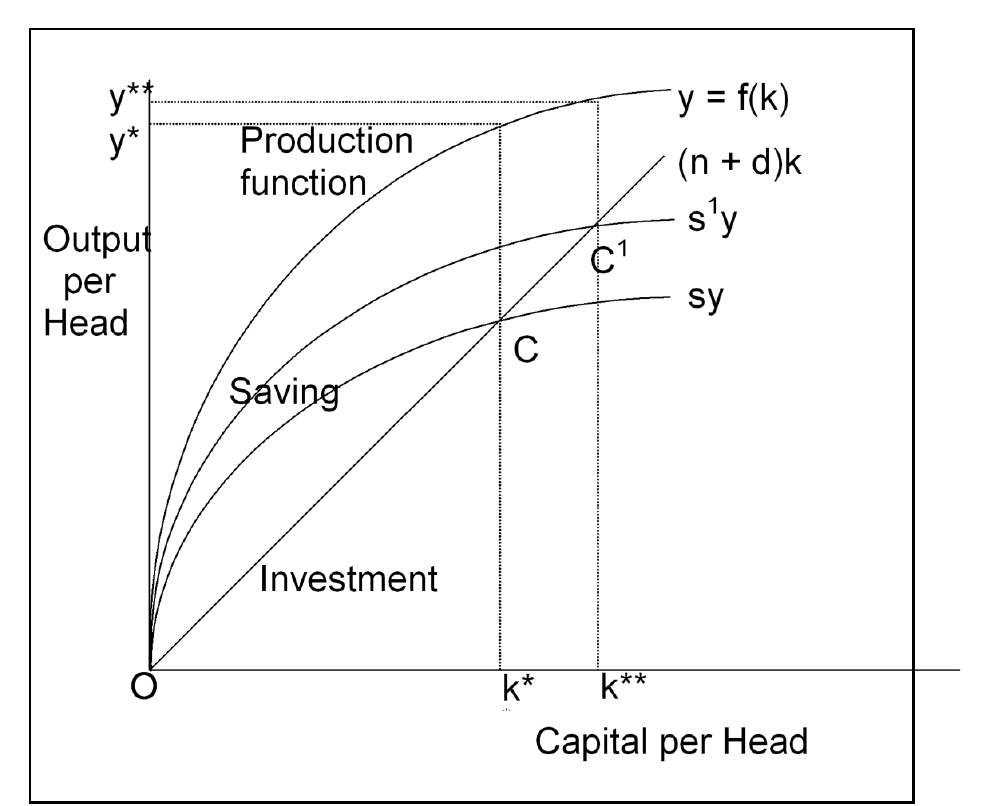
Figure 5. Exogenous technological